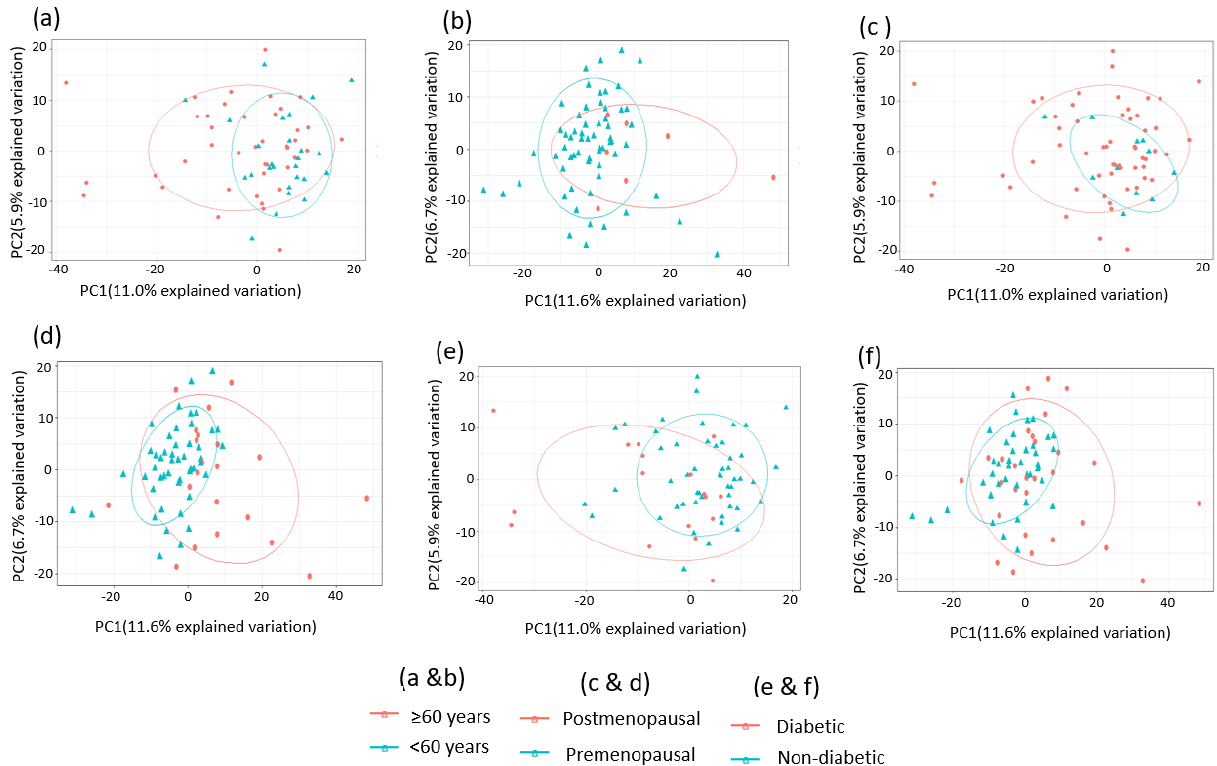
Figure 11. Score plots generated after unsupervised PCA to visualise differences and similarities according to confounding factors. ( a , b ) Score plots according to age (<60 years; ≥ 60 years) for cancers ( a ) and controls ( b ). ( c , d ) Score plots according to menopausal status for cancers ( c ) and controls ( d ). ( e , f ) Score plots according to diabetes (present; not present) for cancers ( e ) and controls ( f ).